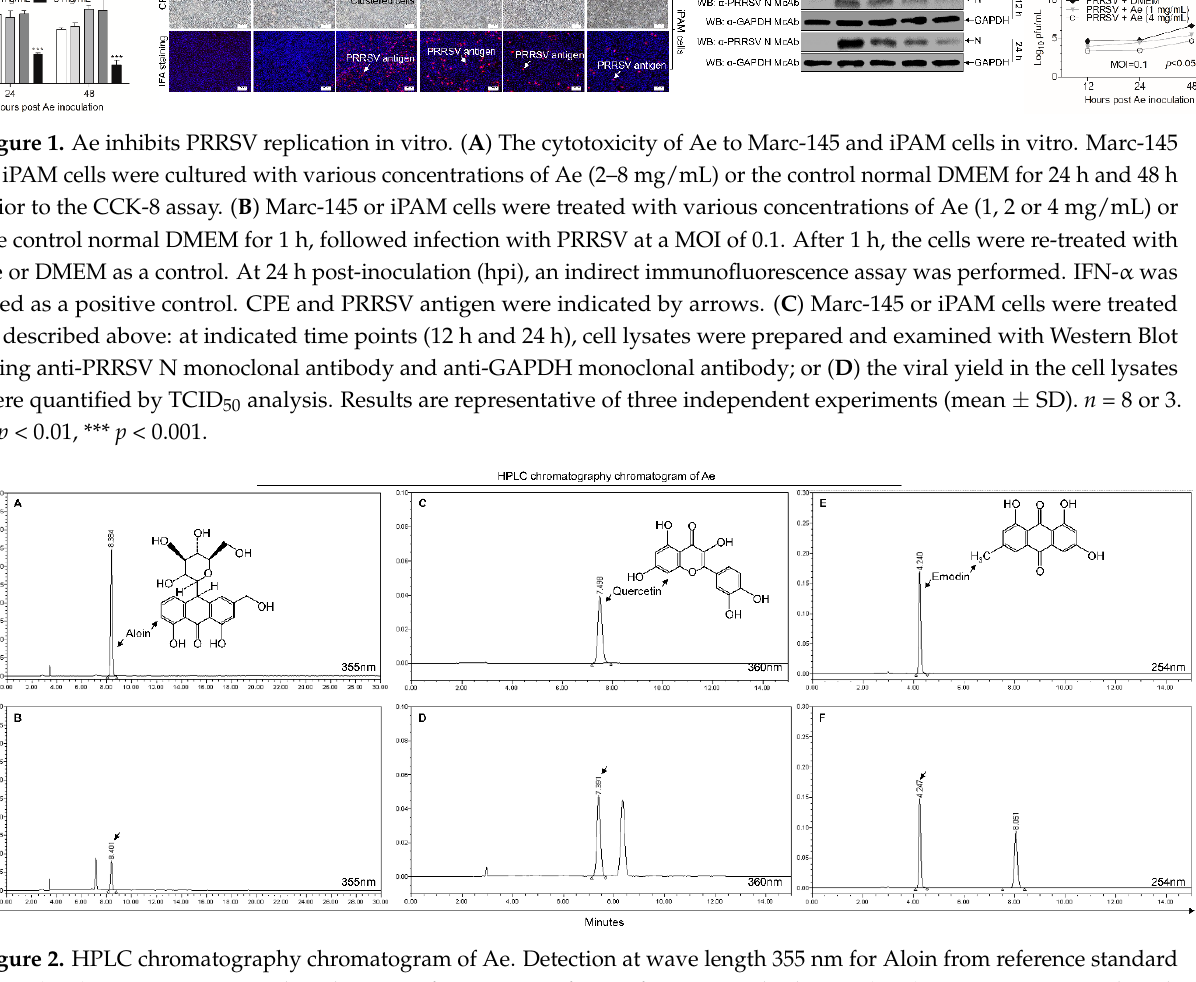
Figure 2. HPLC chromatography chromatogram of Ae. Detection at wave length 355 nm for Aloin from reference standard or Ae ( A , B ). Detection at wave length 360 nm for Quercetin from reference standard or Ae ( C , D ). Detection at wave length 254 nm for Emodin from reference standard or Ae ( E , F ). To investigate the potential cytotoxicity caused by these components of Aloe , CCK-8 assay was performed to test the cytotoxicity of Aloin, Emodin or Quercetin in Marc-145 and iPAM cells. As shown in Figure 3A, the relative viability of Marc-145 or iPAM cells was 100% after treatment with Aloin and Quercetin at the concentration of 400 μ g/mL for 24 h and 48 h, as compared with the controls. Interestingly, the safe concentrations of Emodin in Marc-145 and iPAM cells were 100 μ g/mL, 6.25 μ g/mL, respectively, indicating that different components have different cytotoxicity in the same cells, and the same component can have different cytotoxicity in different cells. After determining the